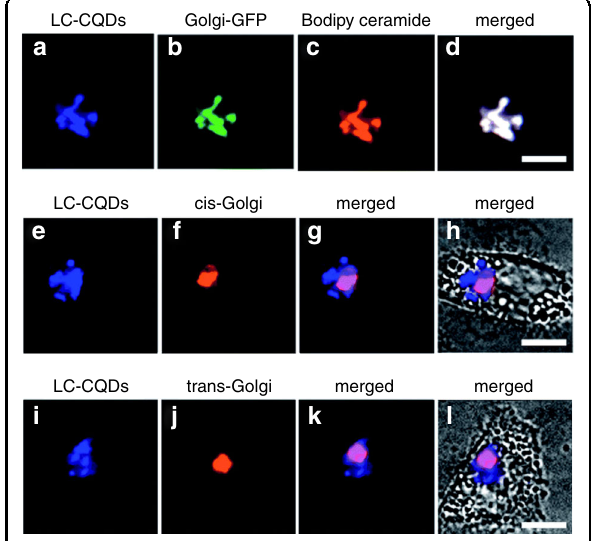
Fig. 8 Targeting the Golgi apparatus with L-cysteine capped carbon dots. a – c Fluorescence image of the L-cysteine capped carbon dots (blue), Golgi-GFP (green, Golgi apparatus speci fi c green fl uorescent protein), and Bodipy ceramide (red, Golgi speci fi c dye) in a human epithelial cell. d Merged image of a – c . e Fluorescence image of L-cysteine capped carbon dots. f Immuno fl uorescence image of the cis-Golgi. g, h Merged images of the fl uorescence and bright fi eld images. i Fluorescence image of L-cysteine capped carbon dots. j Immuno fl uorescence image of the trans-Golgi. k, l Merged images of the fl uorescence and bright fi eld images. (Scale 10 μ m). Figure